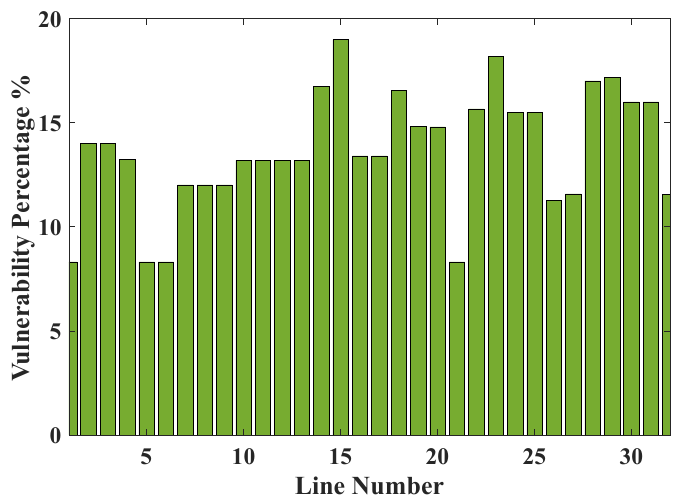
Figure 7. Illustration of the vulnerability analysis of the lines for strategy 2.